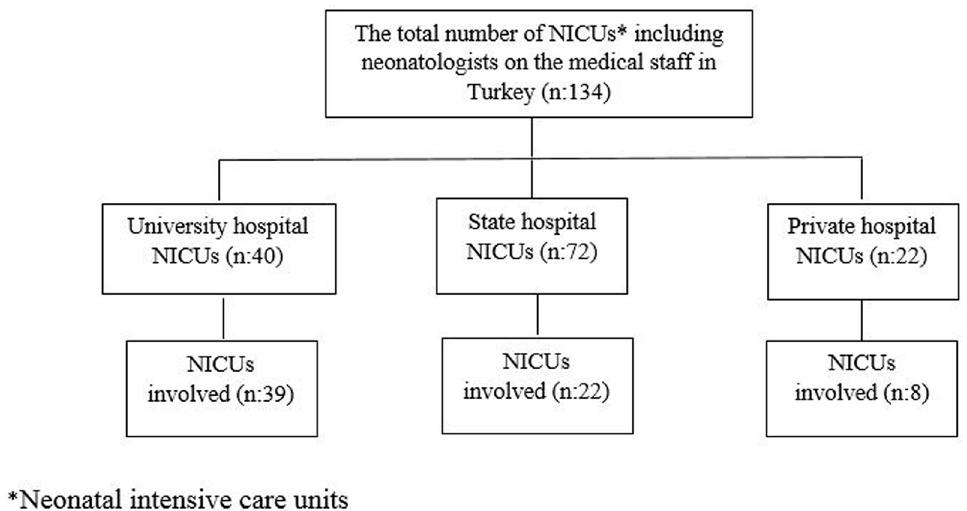
Fig 1. Flow diagram of participant selection and study design. Mo = months; CF-PCM-: chronic form of PCM; ASF-PCM: acute-subacute form of PCM.